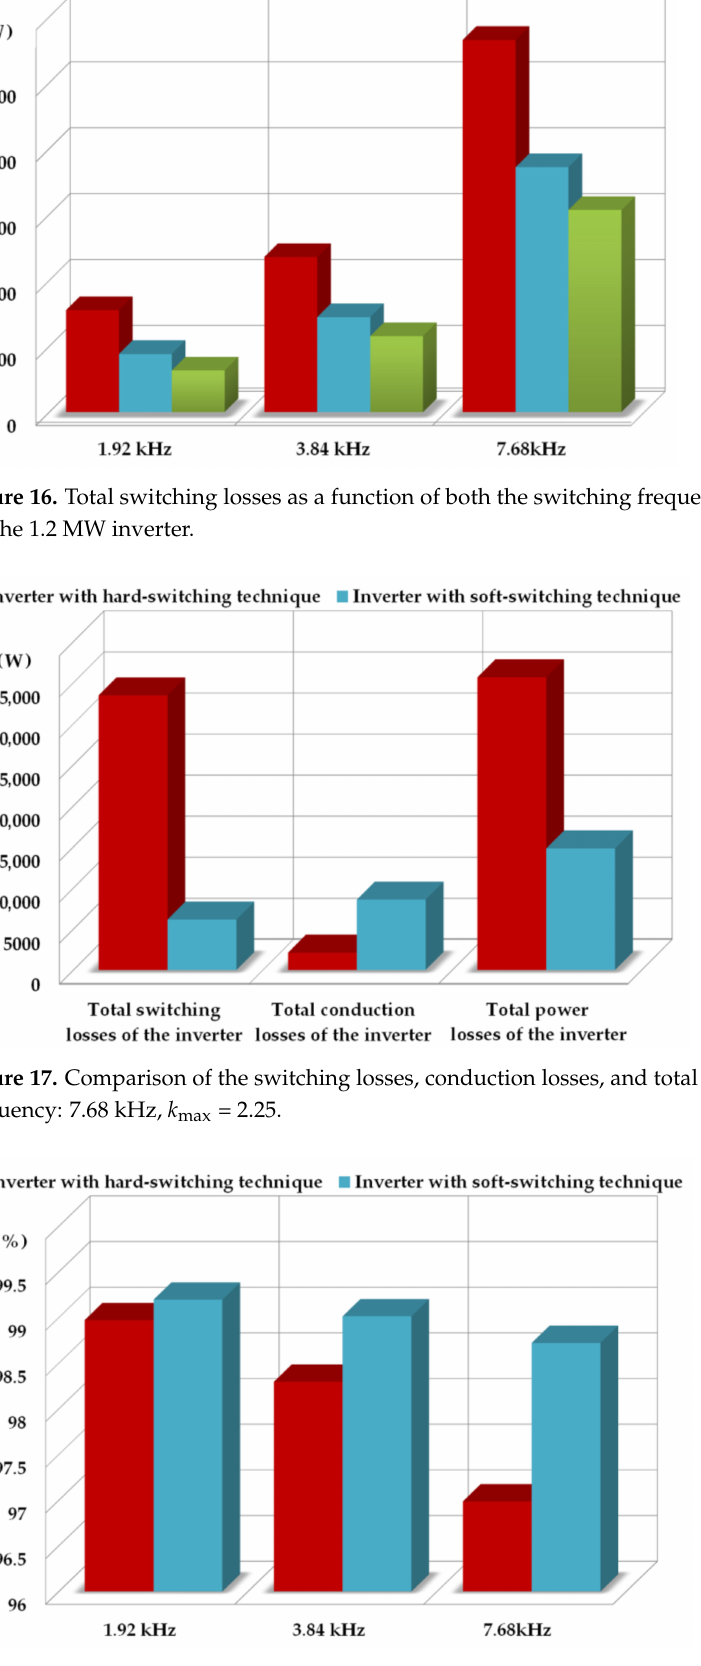
Figure 18. Efficiencies for 1.2 MW inverters; k max =